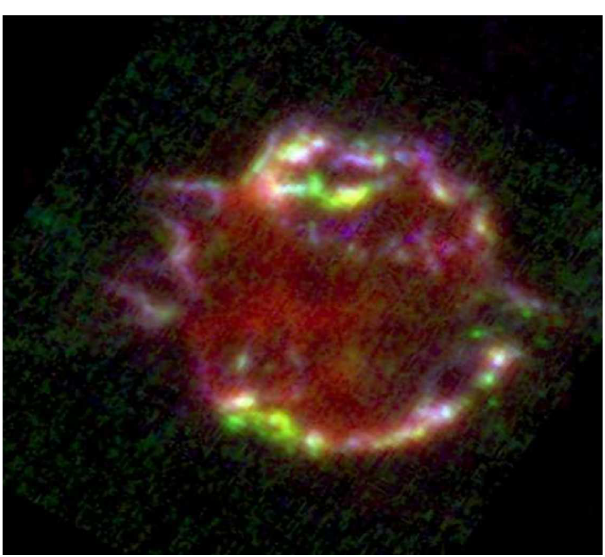
Fig. 3. An example of the data projected out from the data cube (spectral map). This Spitzer Space Telescope image (Program Id 3310) was created from a data cube by selecting certain wavelength regions for the image colors (red – [O IV] 25.91 (cid:22) m, green – [Ne II] 12.81 (cid:22) m, blue – [Ar II] 6.985 (cid:22) m line emission).